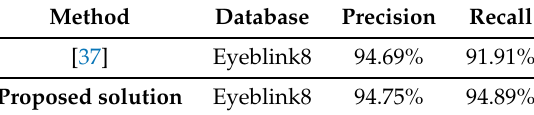
Table 3. Iris center results compared to other